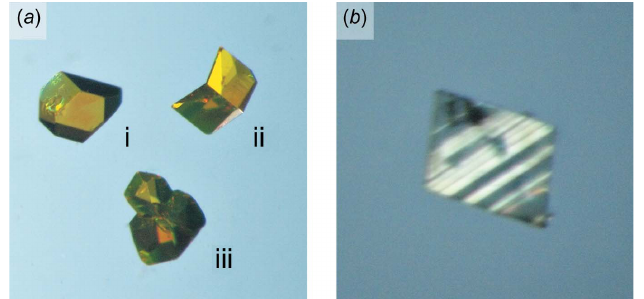
Figure 1 ( a ) Crystalline samples viewed between (partially) crossed polarizers of (i) a single crystal, (ii) a twin showing a re-entrant angle and different optical transmission on either side of a twin plane, and (iii) an